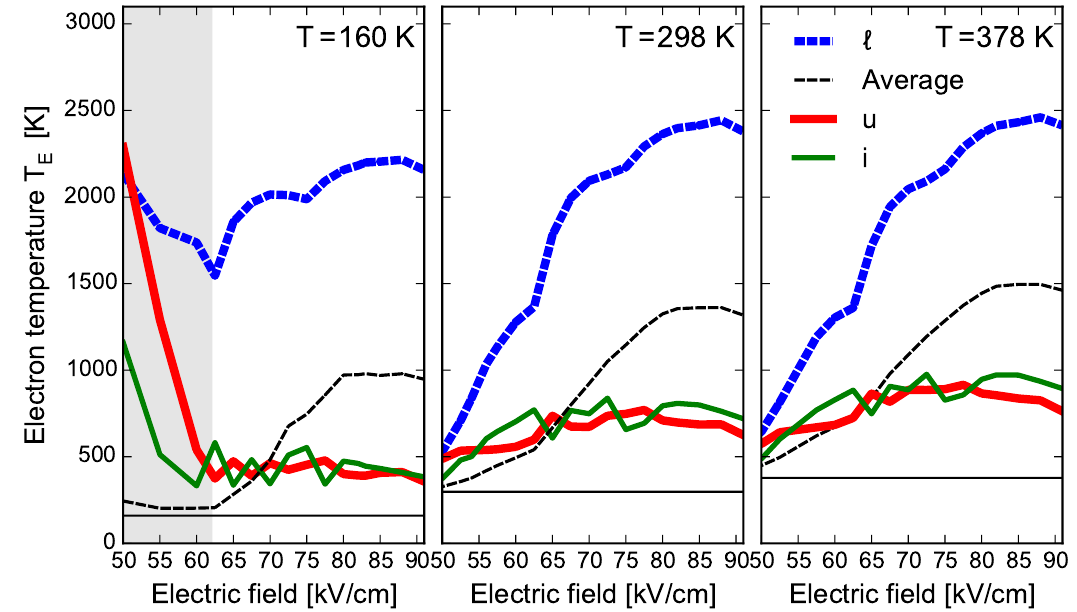
Figure 4. Electron temperature in the upper, lower, and injector states as a function of electric field. Solid horizonal lines denote the lattice temperature. Note that the electron temperatures are not fitting parameters, but calculated using Equation (1e). Also shown is the weighted average (weights are occupations) of the electron temperatures of all subbands. In the grayed area for T = 160 K, the considered states had vanishing occupations, so the high electron temperatures at low fields are not